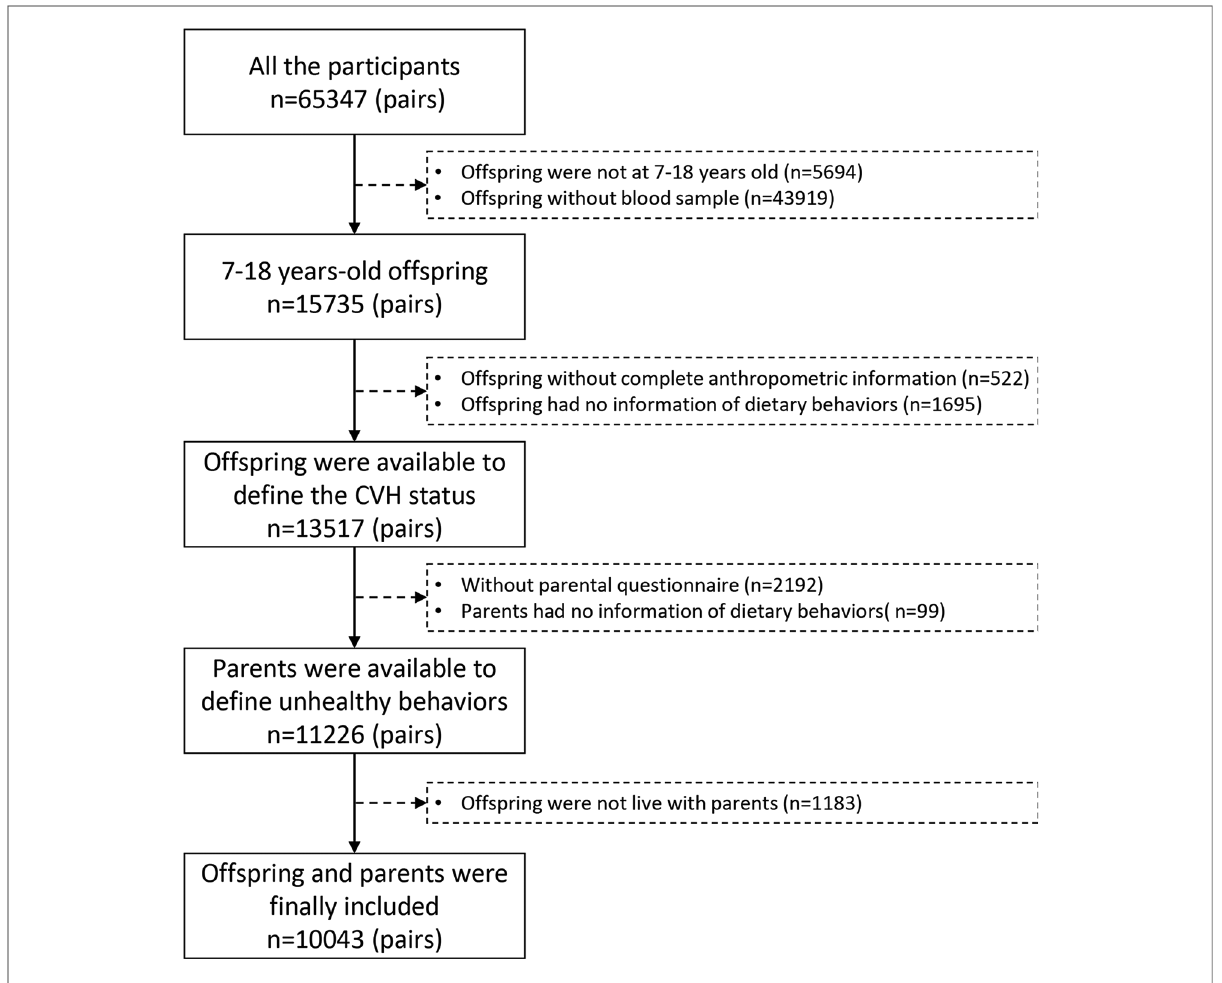
FIGURE 1 Selection process of the participants. CVH, cardiovascular